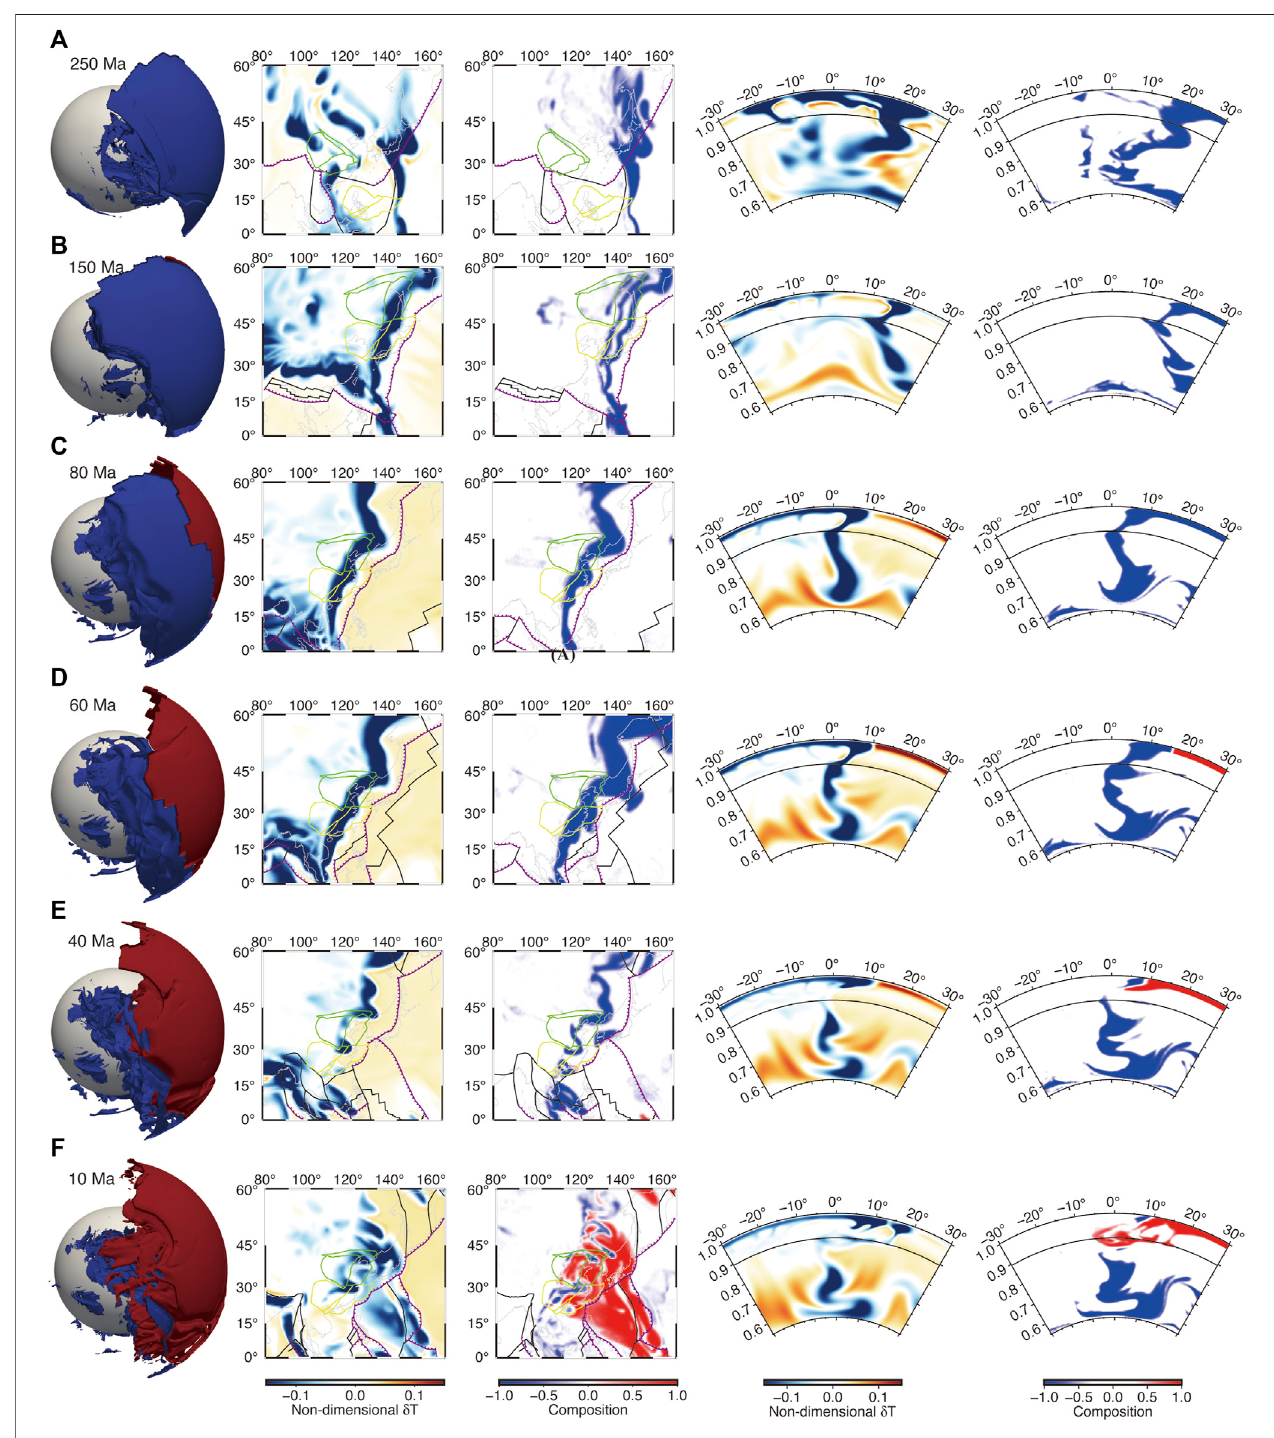
FIGURE 3 | Slab structures of the Izanagi-Paci fi c plate from case 1 at (A) 250 Ma, (B) 150 Ma, (C) 80 Ma, (D) 60 Ma, (E) 40 Ma and (F) 10 Ma. The fi rst column showsthe3DslabstructuresoftheIzanagiplate(blue)andthePaci fi cplate(red)attheEasternAisaregion.Thesecondandthirdcolumnsshowtheresidualtemperature and composition fi elds at 670 km depth, respectively. Convergent and ridge and transform boundaries are represented by magenta and black lines, respectively. The fourth and fi fth columns show the cross-section of residual temperature and composition fi elds at section P3 as shown in Figure 1 . In fi gures of compositional fi elds, the blue and red colors denote the Izanagi plate and the Paci fi c plate, respectively. A full-time evolution of the slab structures is provided in Supplementary Figure S2 .